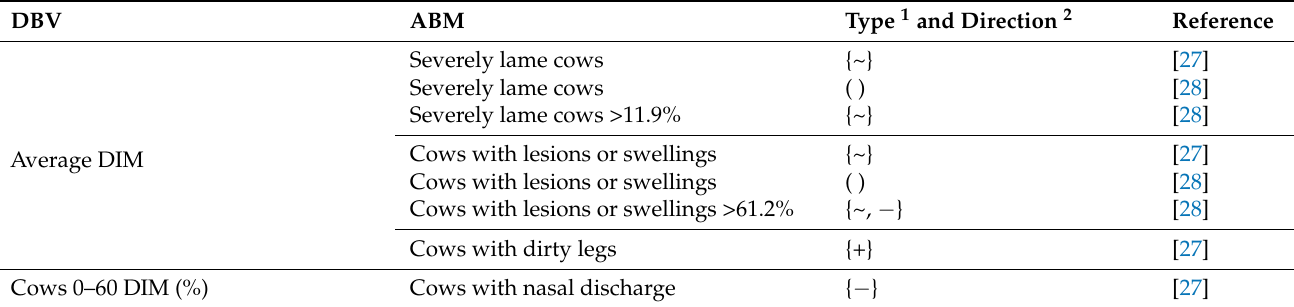
Table 10. Associations between data-based variables (DBVs) based on days in milk and animal-based measurements (ABMs) extracted from two scientific